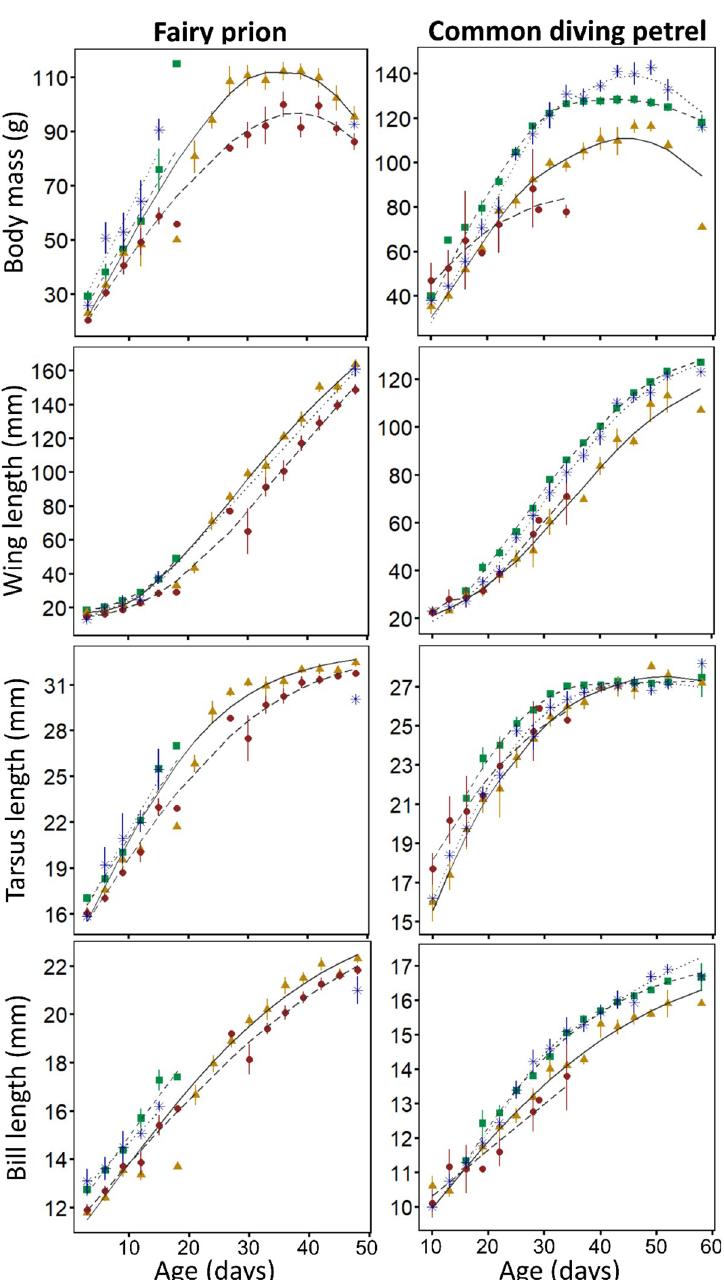
Fig 3. Growth curves of chick fairy prions ( Pachyptila turtur ) and common diving petrels ( Pelecanoides urinatrix ) from Kanowna Island in 2017/18 (green squares), 2018/19 (orange triangles), 2019/20 (red circles) and 2020/21 (blue